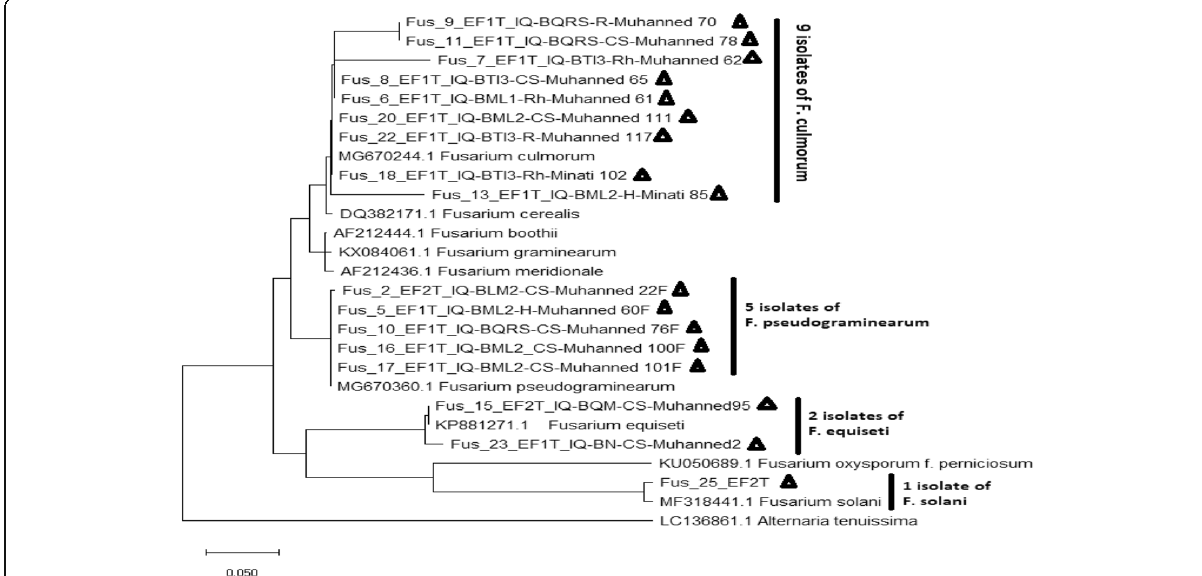
Fig. 13 Phylogenetic tree generated with the TEF1- α sequences of the 17 Fusarium isolates, as inferred from the maximum likelihood (ML) analyses (determined by black triangles) and related species retrieved from GenBank. TEF1- α gene sequence of Alternaria tenuissima (LC136861.1) was used as the out-group